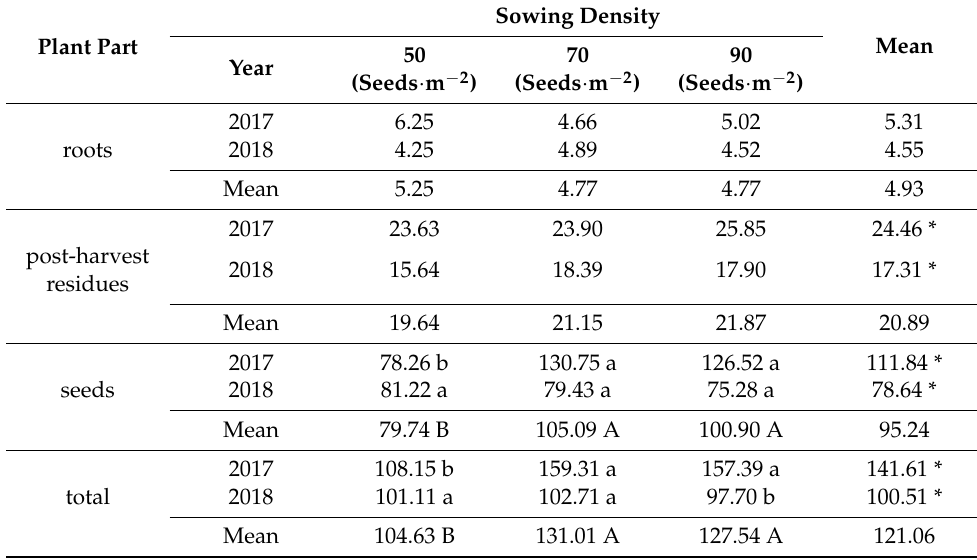
Table 4. Total nitrogen amount concentration by soybean, kg N · ha − 1